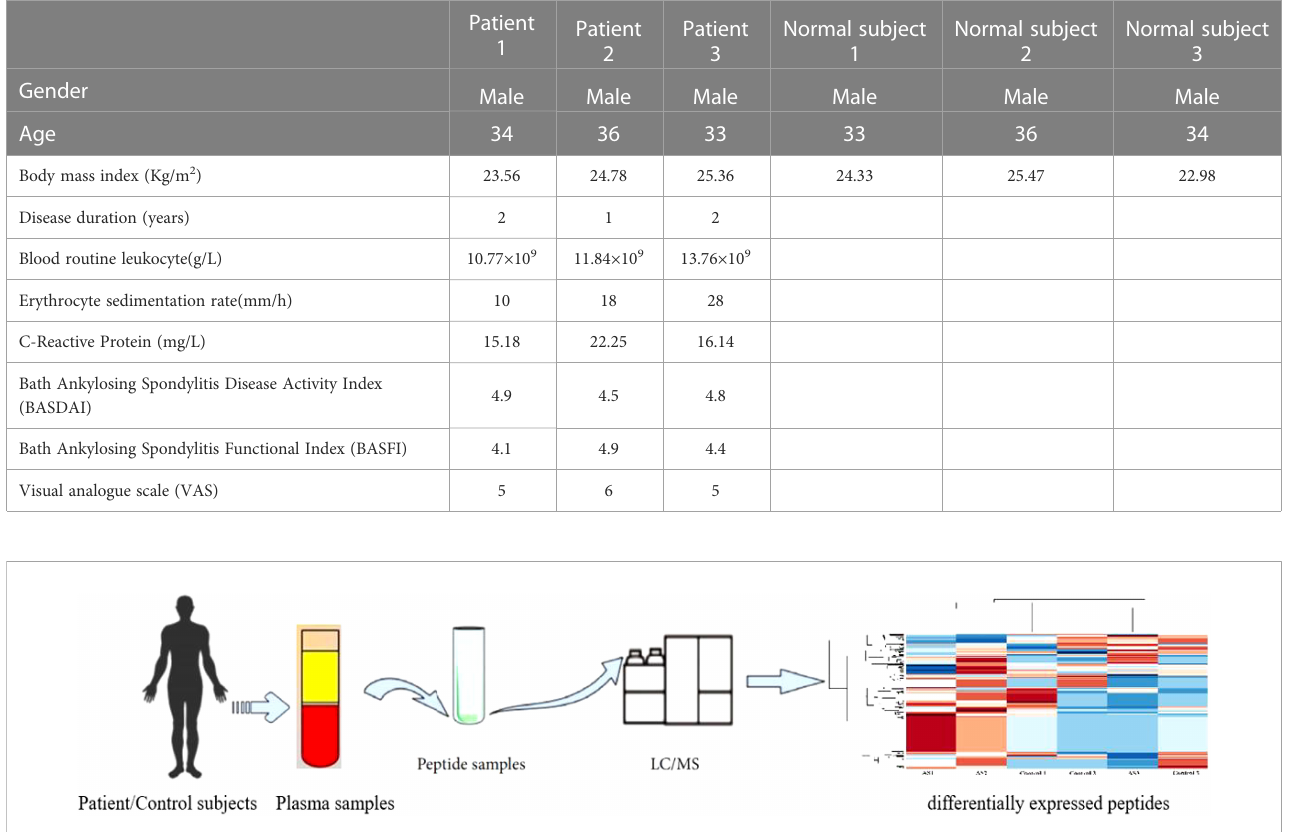
FIGURE 1 The process of peptide identi fi cationin peripheral blood in patients with ankylosing spondylitis by LC/MS mass